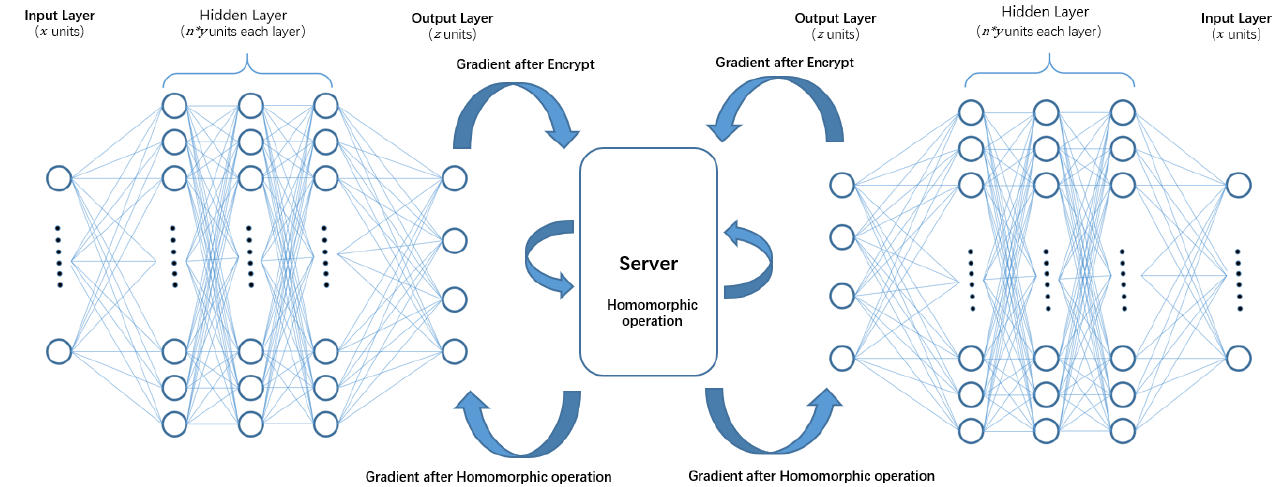
Figure 5. The flow chart of the Paillier federated multi-layer perceptron algorithm.